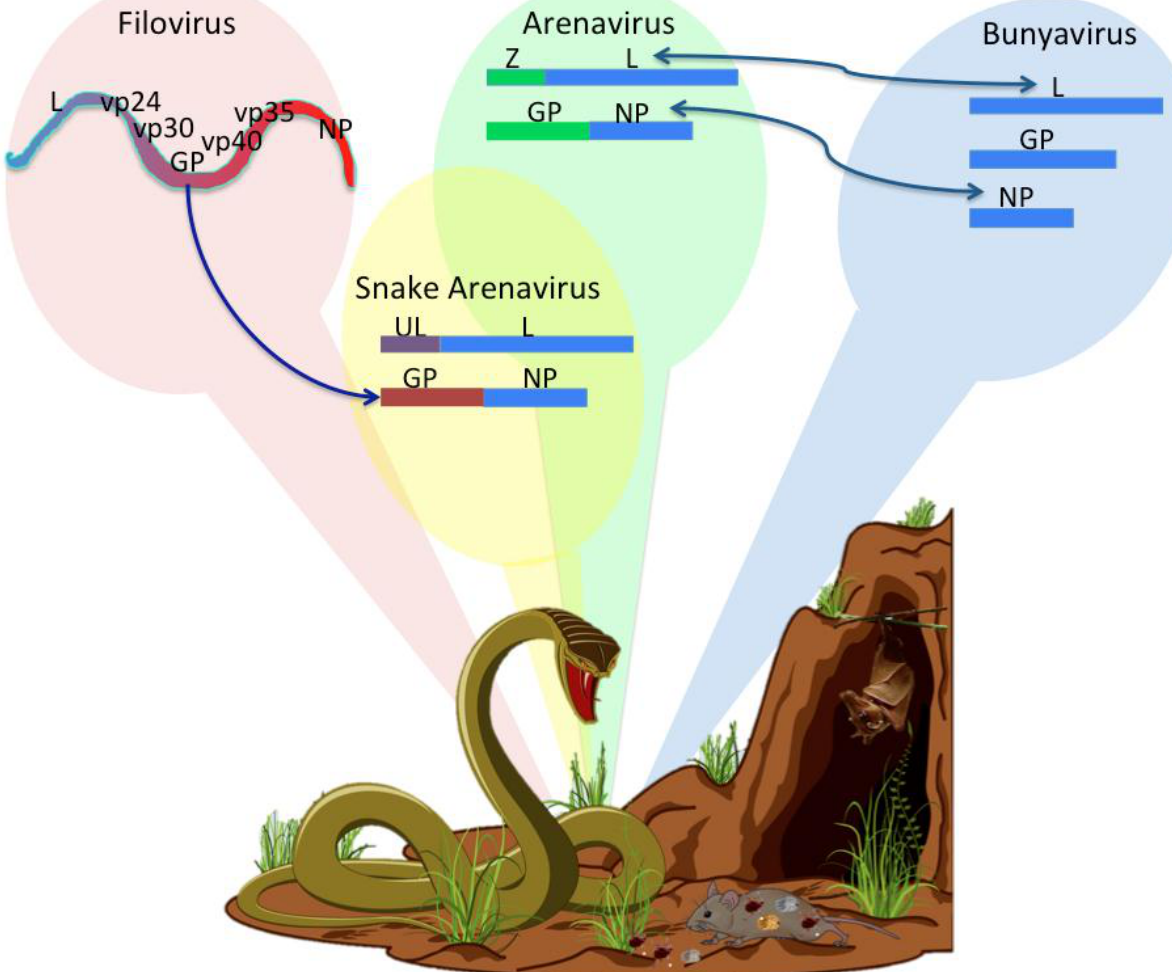
Figure 6. Arenavirus Evolution. The upper diagram shows the genomic structure and proteins encoded by filoviruses, arenaviruses, bunyaviruses, and the newly-discovered snake “arenavirus”. The blue arrows show the hypothetical changes that occurred in the arenaviral ancestors. The new snake virus has the L and NP genes of an arenavirus, but the GP of a filovirus and the Z gene similar to a cellular ubiquitin ligase (UL). The lower diagram shows how the reservoirs of arenaviruses, filoviruses, and bunyaviruses can interact with each other in the same ecological niche allowing co-infections and mixing of viral genomes to produce new viruses (Modify from